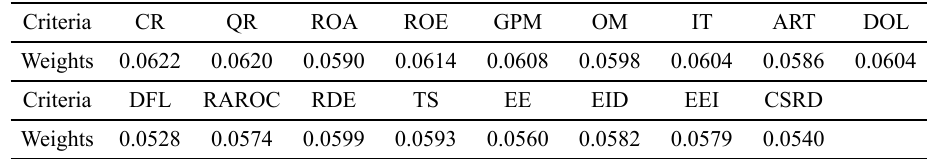
Table 1. Criteria weights in the limit